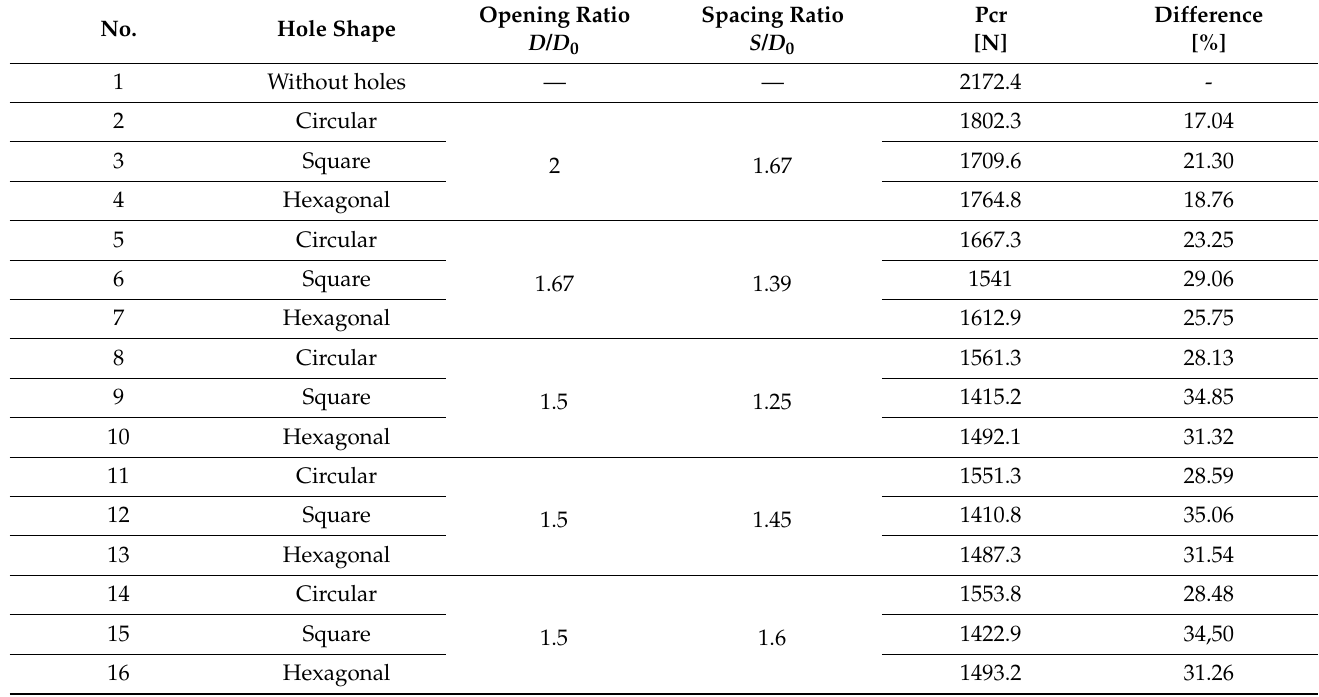
Table 3. Buckling load value for all tested cases for P1 composite configuration.